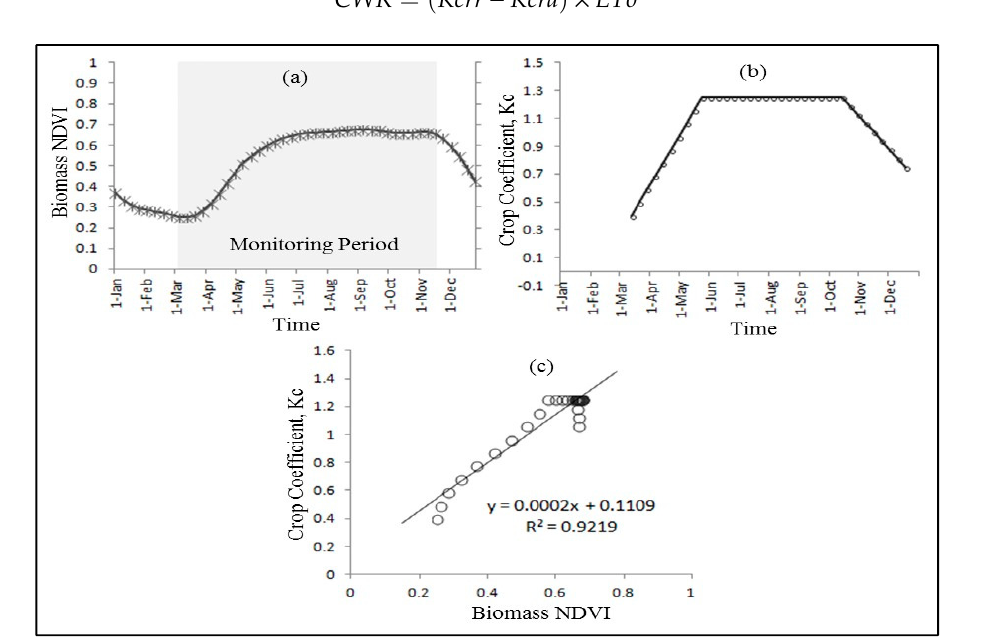
Figure 7. ( a ) NDVI profile of sugarcane crop, ( b ) Corresponding FAO defined crop coefficients (Kc values), and ( c ) Linear regression calculation between NDVI and Kc values.